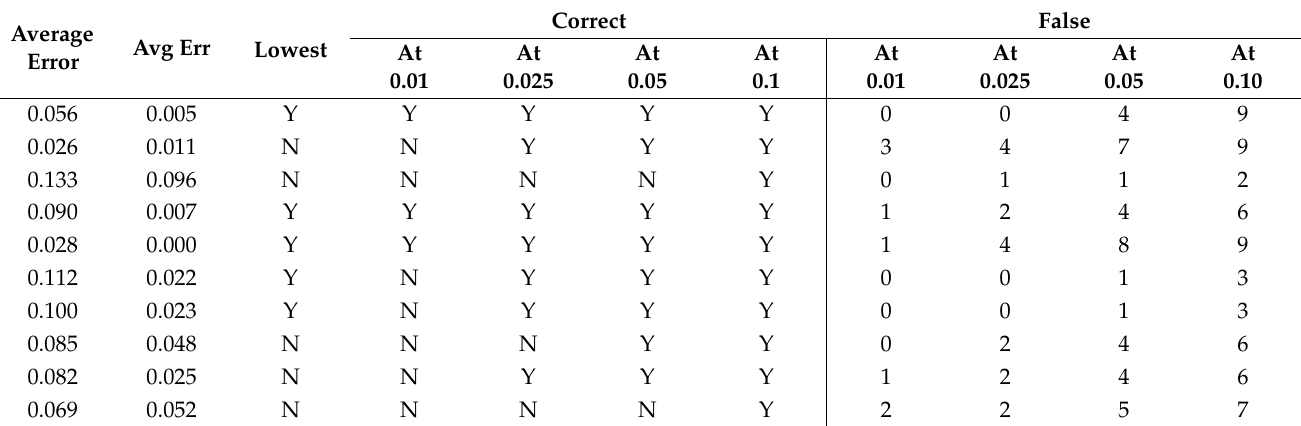
Table 7. Set 3, trials 1–10 summary data (single 0.5 PR value).